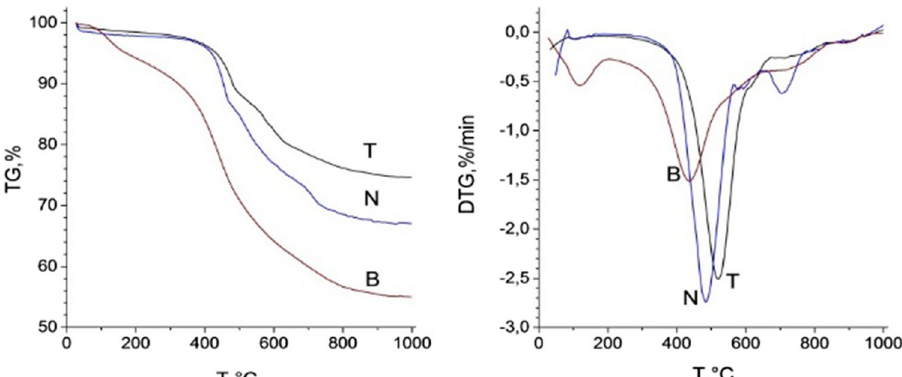
Fig. 5 TG/DTG curves of coal pyrolysis (heating rate of 10 °C/ min)